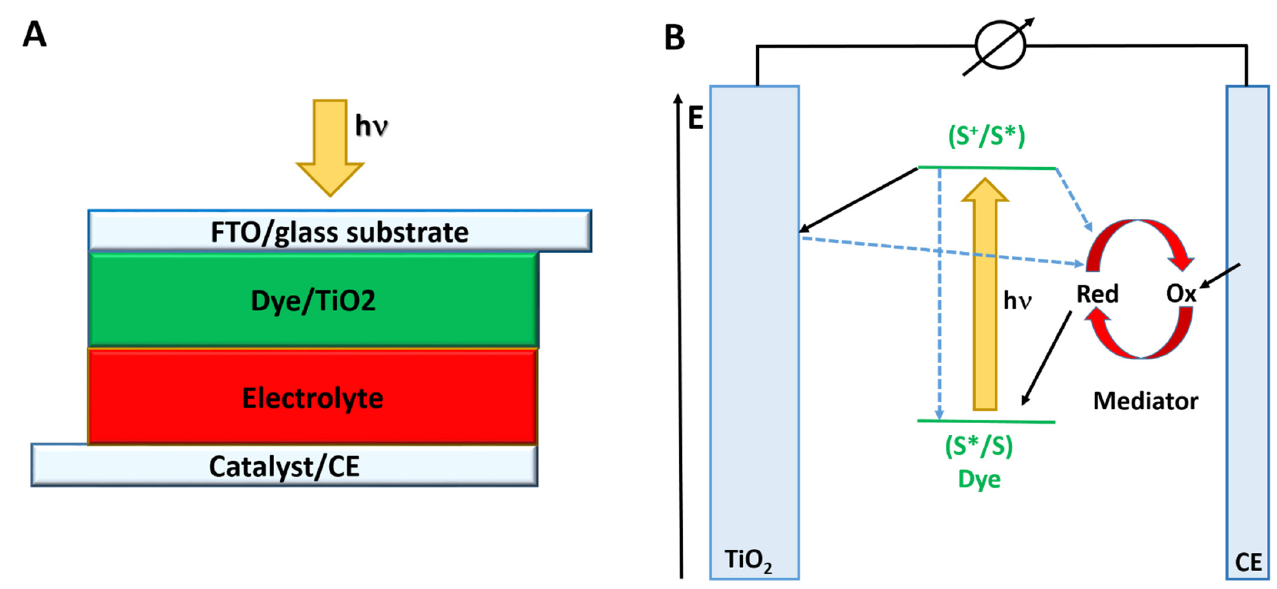
Figure 1. ( A ) The schematic structure and ( B ) main processes and principles of operation of the dye-sensitized solar cell.